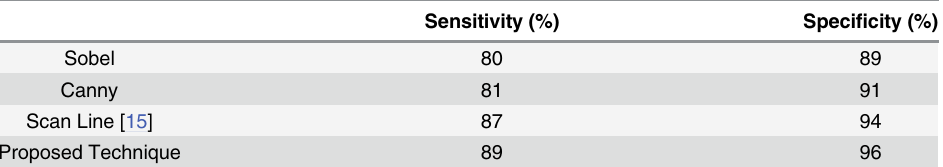
Table 4. Comparison for sensitivity and